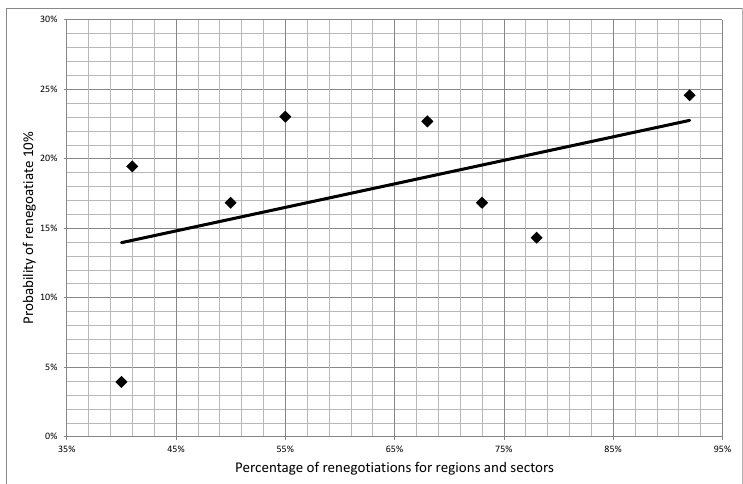
Figure 2. Percentage of renegotiations and the probability of renegotiation. Source: Own calculations based on data from Guasch et al.